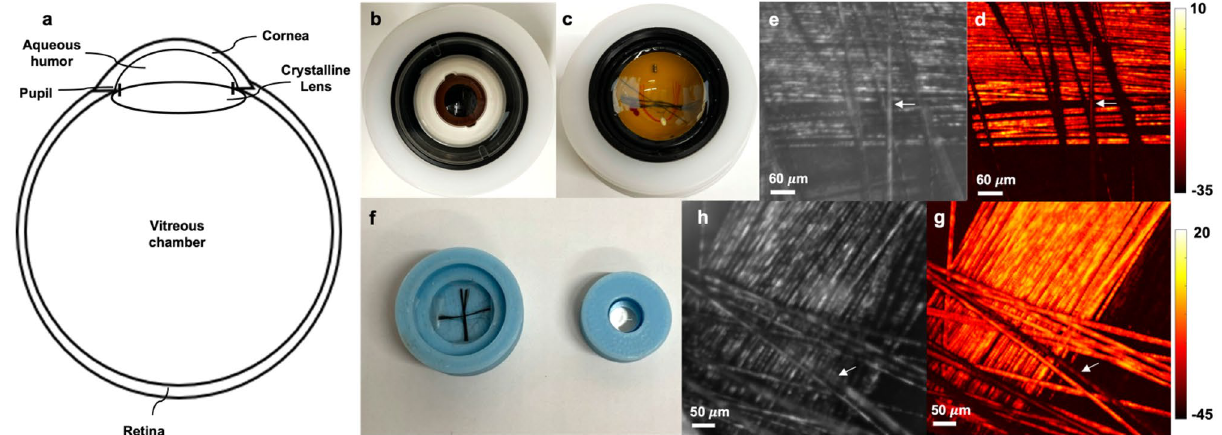
Figure 2. Imaging phantom eye models for human and rat. Simplified eye model consisting of the cornea, aqueous humor, pupil, crystalline lens, vitreous chamber, and the retina. ( a ) Human eye model ( b ). Strings of 7 μm carbon fibers are placed at the bottom of the eye model ( c ). CF image acquired with PARS scattering mechanism ( d ). CF image acquired using PARS absorption mechanism ( e ). Custom rat eye model consisting of a single achromatic lens and a 3D printed plastic chamber and strings of carbon fibers ( f ). PARS scattering and absorption contrast images, respectively ( g , h ). PARS excitation and detection beams are co-aligned so that the same CF are in focus in both images (white